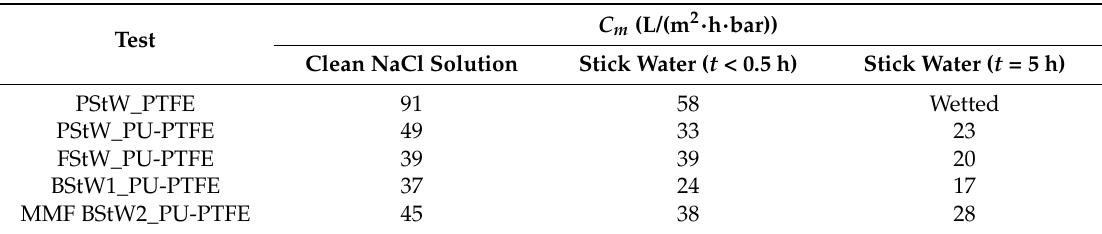
Table 3. C m values calculated from clean solution testing on fresh membranes, and after 5 h of stick water